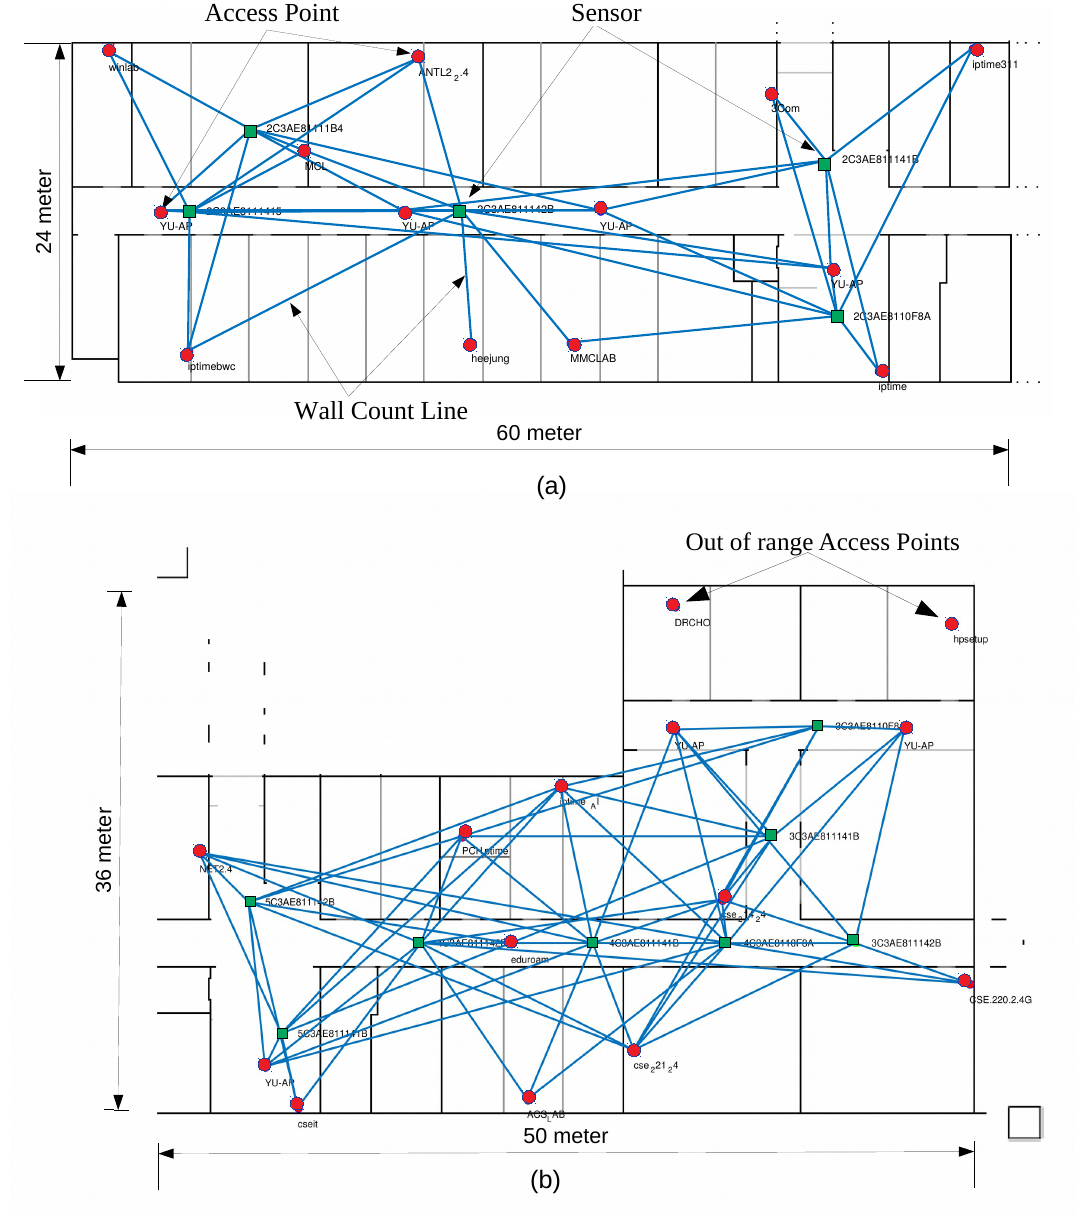
Figure 6. Experimental Setup. Sensors (green rectangles), access points (red circles), And the blue lines emerging from the sensors represent the distance of the access points present in the range of the corresponding sensor. ( a ) ICE Department and ( b ) CS